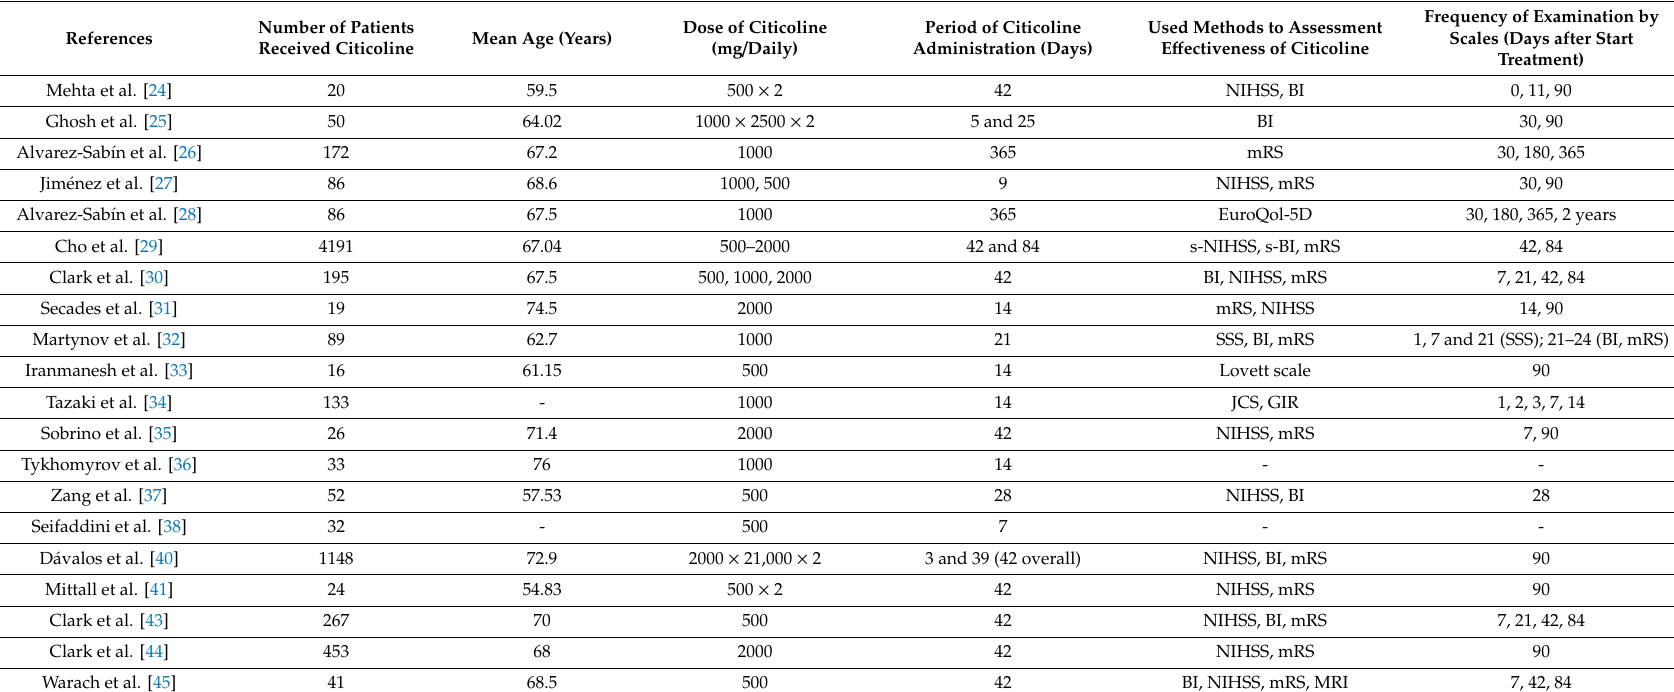
Table 2. The most important features of research based on patients after a stroke